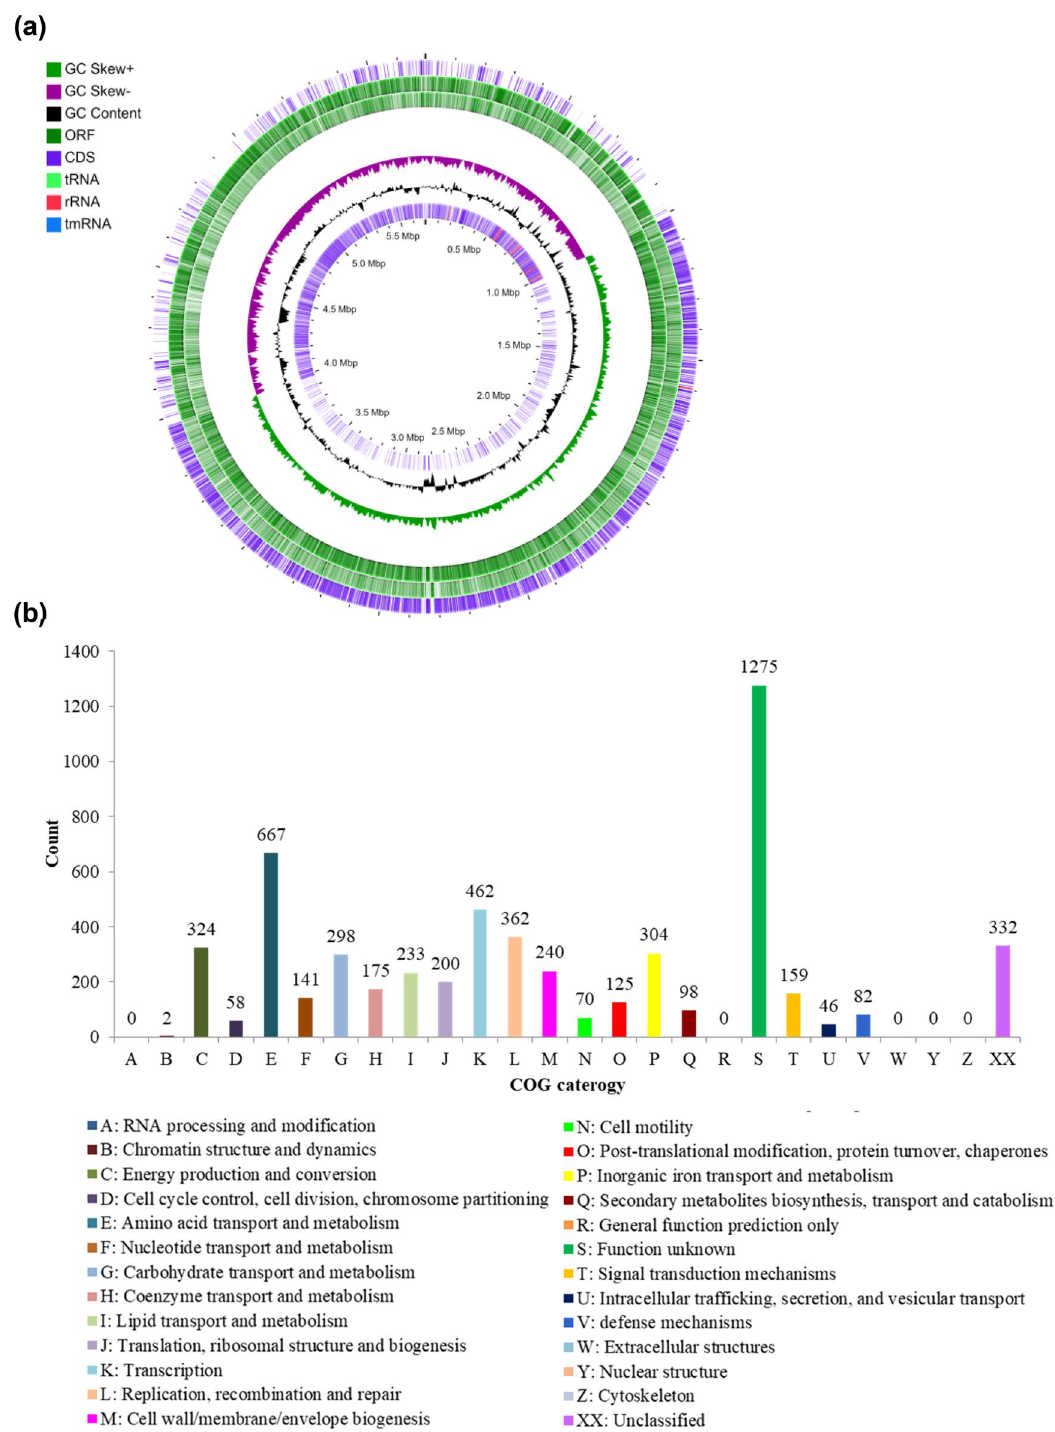
Figure 3. Analysis of the whole genome sequence and biosynthetic gene clusters (BGCs) of Peribacillus frigoritolerans BE93. ( a ) Circular whole genome map with marked characteristics. ( b ) Clusters of orthologous group (COG) classification of coding sequences (CDS) based on eggNOG annotation. ( c ) Putative BGCs predicted using the antiSMASH 5.0